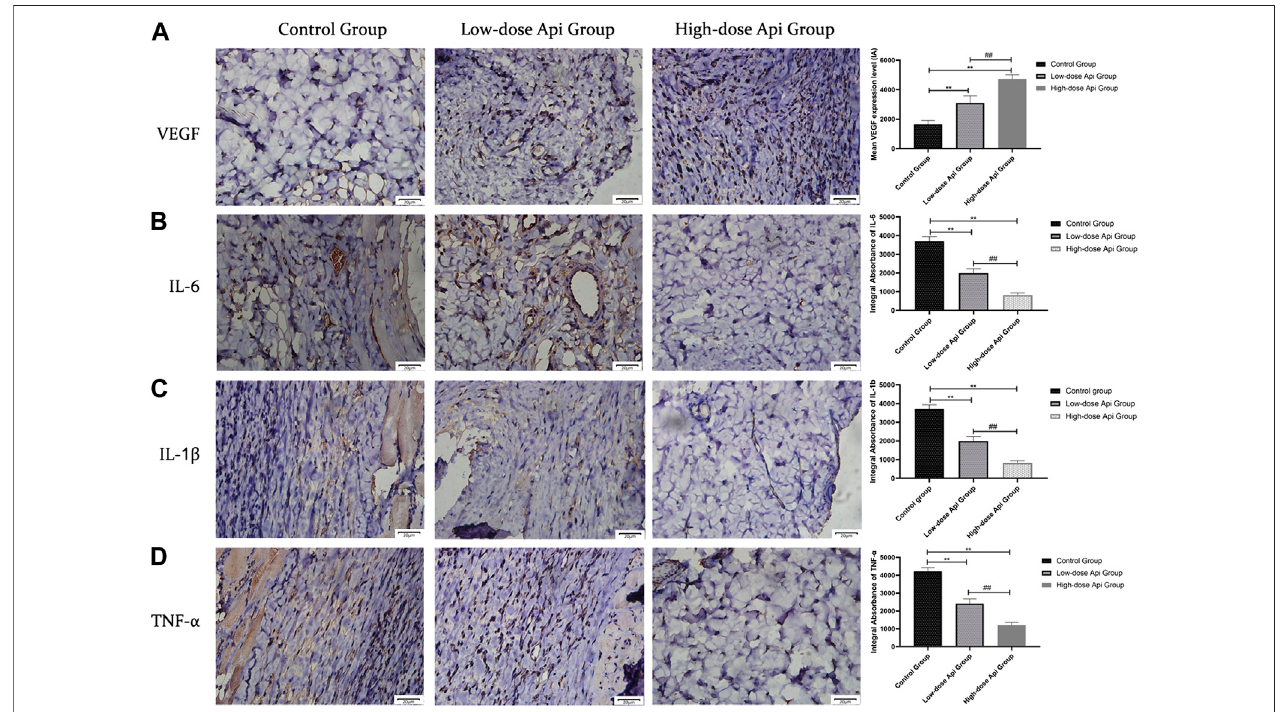
FIGURE 6 | Representative images after immunohistochemical staining for different pro-in fl ammatory cytokines 7 days after the operation (magni fi cation, × 400). Expression levels ofVEGF, TNF- α ,IL-1 β , and IL-6in zone 2ofdorsal fl aps. Api promotedthe expression ofVEGF and inhibited theexpression ofIL-1 β ,IL-6, and TNF- α . ** p < 0.01 vs. control group. ## p < 0.01 vs. Low-dose Api group.